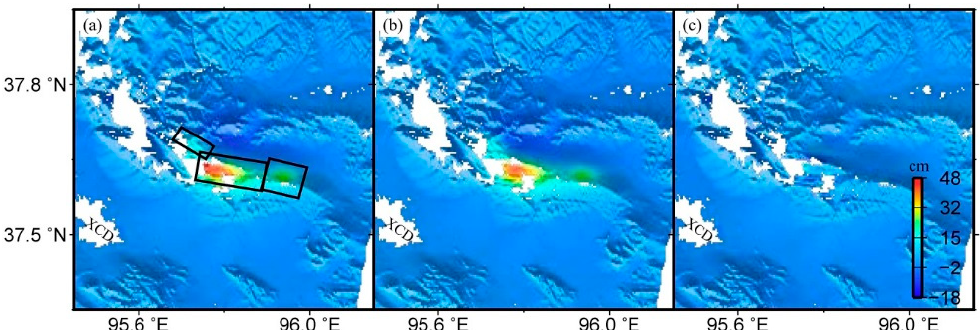
Figure 4. ( a ) Observed coseismic displacements for the 2009 Mw 6.3 DCD earthquake from two Envisat ASAR descending Track 319 images; ( b ) modeled displacements from the coseismic slip distribution in the layered model; and ( c ) residual displacements. Three rectangles in subfigure ( a ) indicate the surface projections of the fault geometry model. XCD is the abbreviated form of Xiaochaidan. Positive and negative values indicate motions toward and away from the satellite in the LOS direction, respectively.